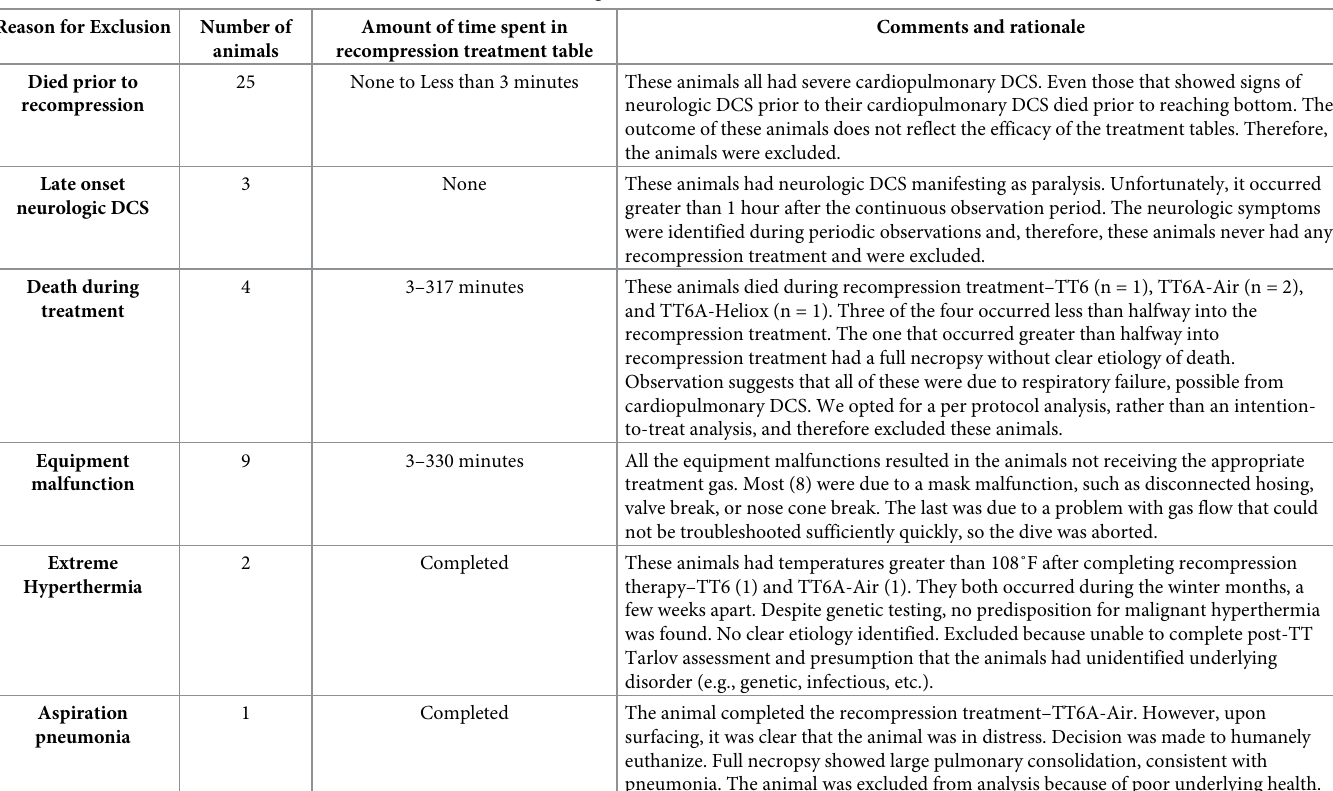
Table 2. Describes the rational for exclusion of animals that had neurologic DCI.